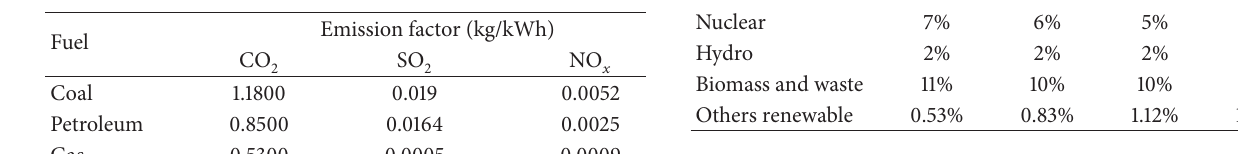
Figure 1: Share of installed capacity as of December 31, 2012, in Malaysia [88]. Table 1: Emission factors of fossil fuels for electricity generation [84].